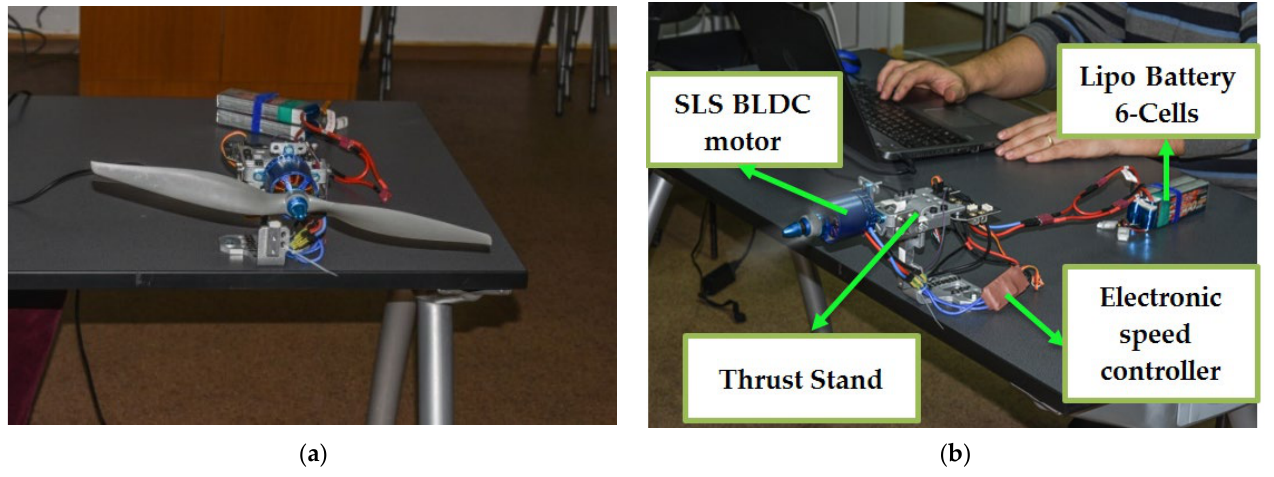
Figure 5. BLDC motor testing: ( a ) initial operation check of test stand; ( b ) BLDC motor performance testing. mance